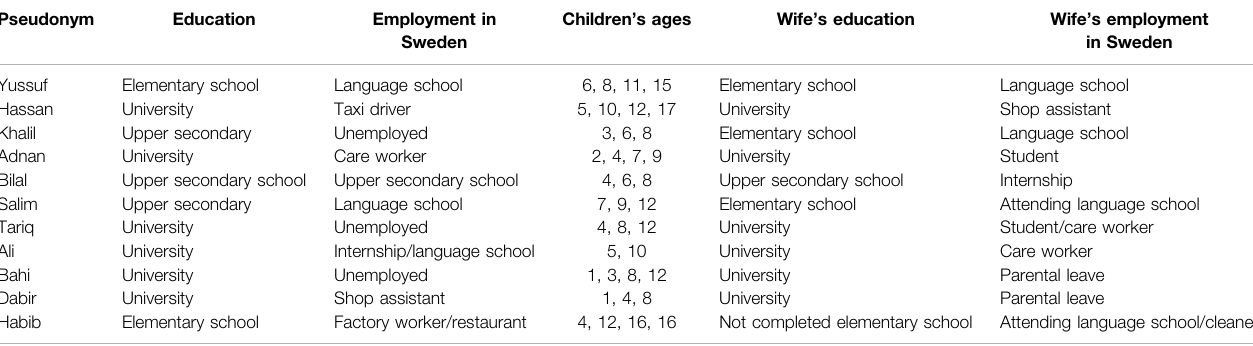
TABLE 1 | Participants ’ educational background and employment situation in